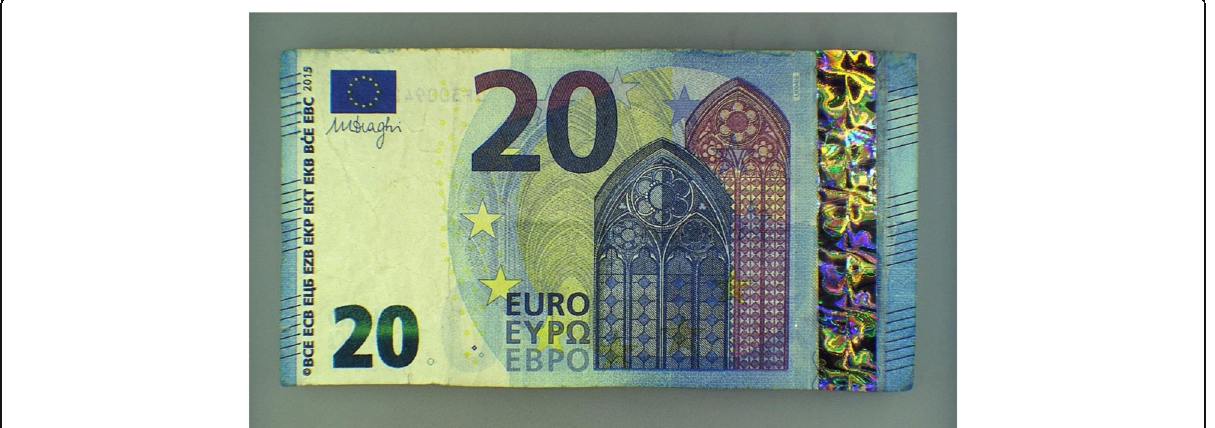
Fig. 3 One of the counterfeits in the test set. The different foil is particularly visible. The counterfeit mimics a EUR 20 banknote from the second